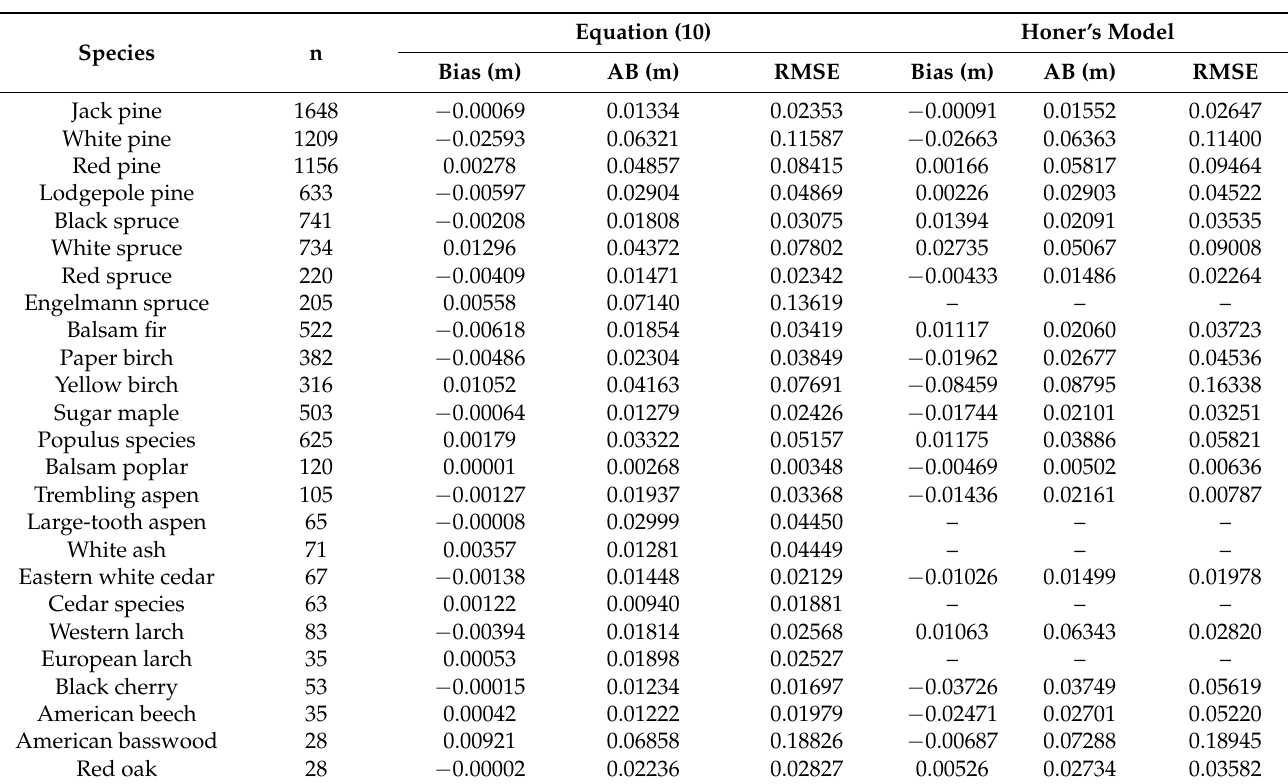
Table 5. Mean bias (observed − predicted), absolute bias (AB), and root mean square error (RMSE) of the residuals from inside bark volume equation (Equation (10)) and Honer et al.’s [14] model for 25 tree species used in this study.